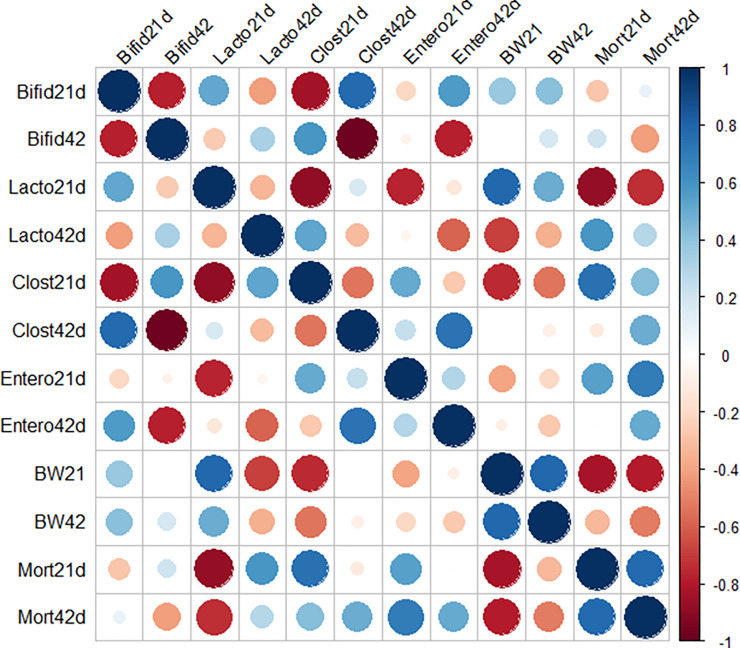
Spearman’s rank correlation matrix of the dominant microbial populations and growth performance parameters.(A) Large circles indicate strong correlations. The colors of the scale bar denote the nature of the correlation with 1 indicating a perfect positive correlation (dark blue) and -1 indicating perfect negative correlation (dark red).